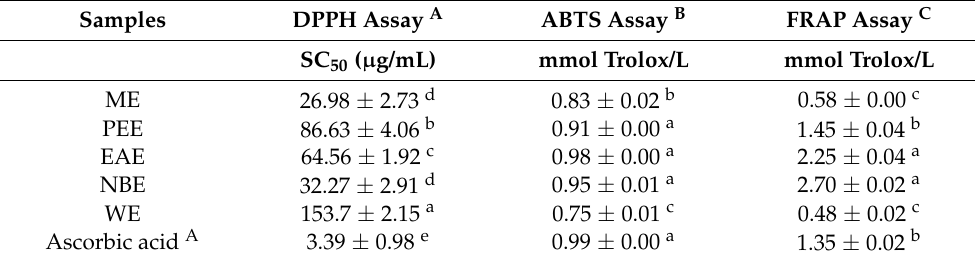
Table 1. Antioxidant activities of methanolic extract and fractions from T. grandis .